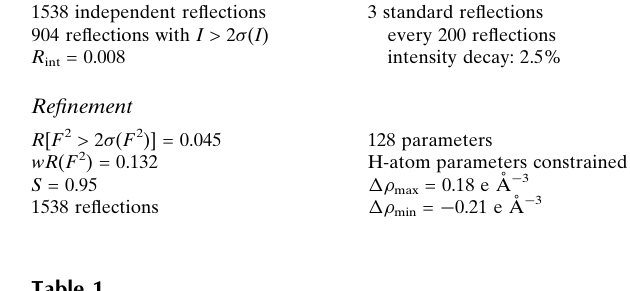
Hydrogen-bond geometry (A˚ , (cid:2)